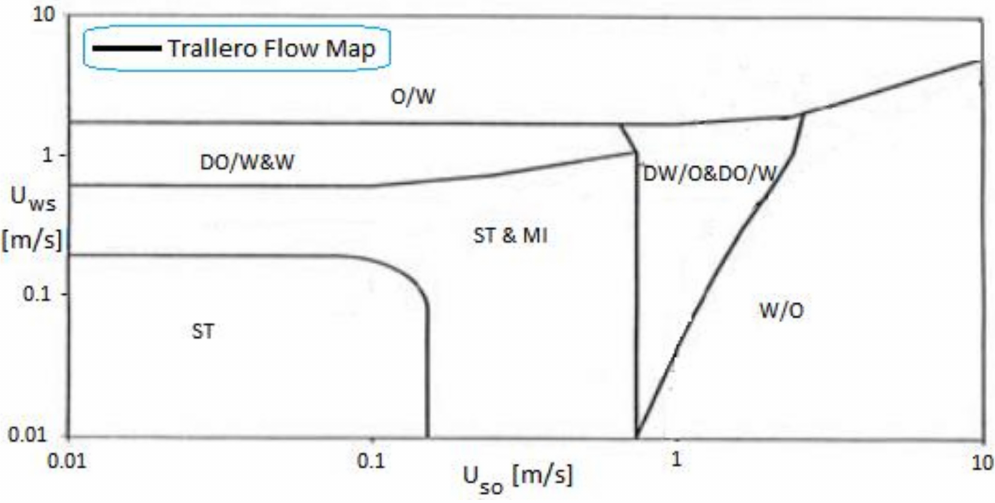
Figure 2. Flow pattern diagram according to Trallero